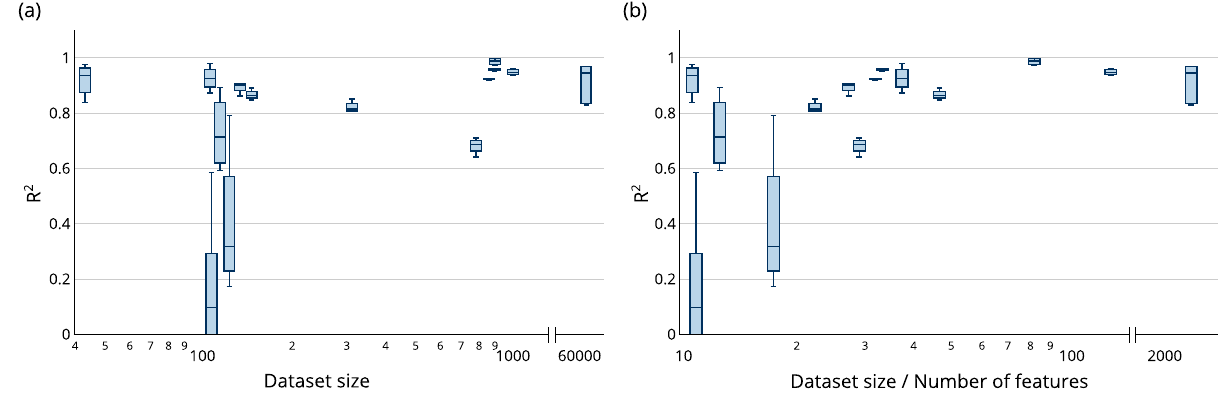
2 Figure 6. The performance R of with respect to the dataset size and shape, one box represents all outer loop 2 runs of one dataset. ( a ) R over dataset size, the boxes are slightly shifted to avoid overlapping, without affecting 2 the interpretation of the graphic. ( b ) R over dataset size divided by number of